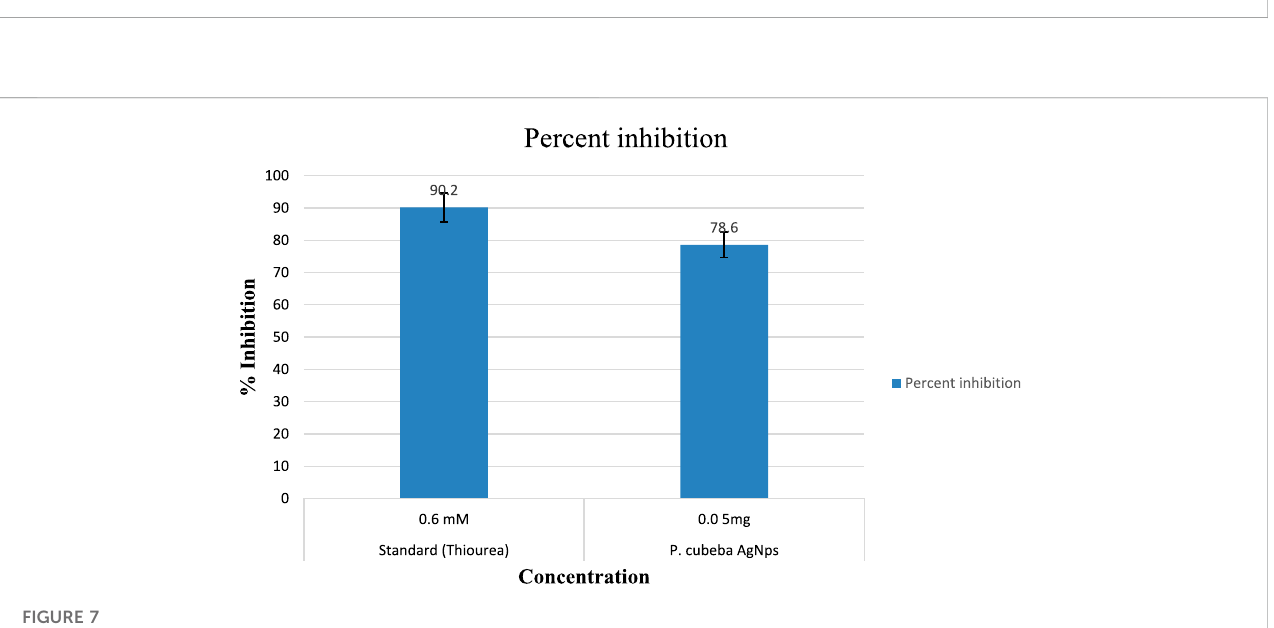
FIGURE 6 Percentage inhibition of the P. cubeba extract.